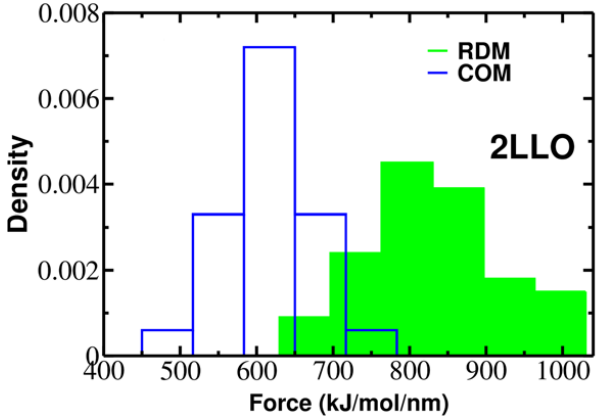
Figure 3. Histograms of rupture forces for 2LLO peptide ‐ protein complex along RDM (green) and COM (blue) directions. The histograms clearly show that force peak moves towards higher values for RDM vector compared to COMs one.